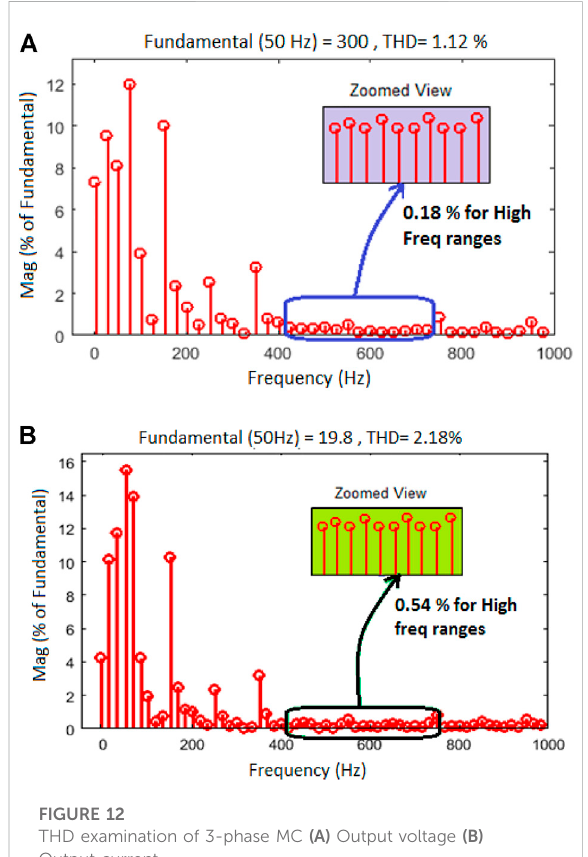
FIGURE 12 THD examination of 3-phase MC (A) Output voltage (B) Output